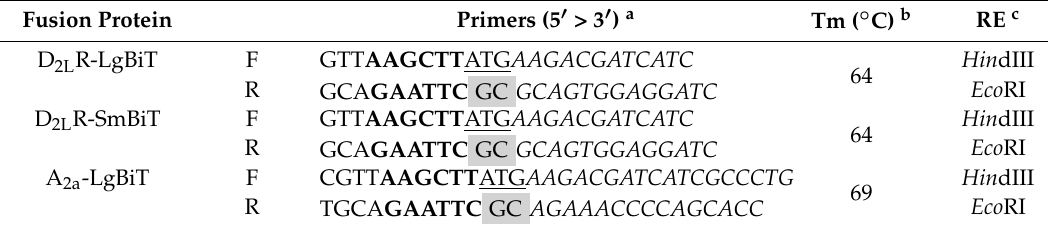
Table 2. Primers for the development of the GPCR–NanoBiT fusion constructs. a: Forward (F) and Reverse (R) primers (5 (cid:48) > 3 (cid:48) ) with restriction enzyme sites ( bold ), start codon (underlined) or extra nucleotides ( marked in grey ) to ensure a correct reading frame. b: Annealing temperature. c: Restriction